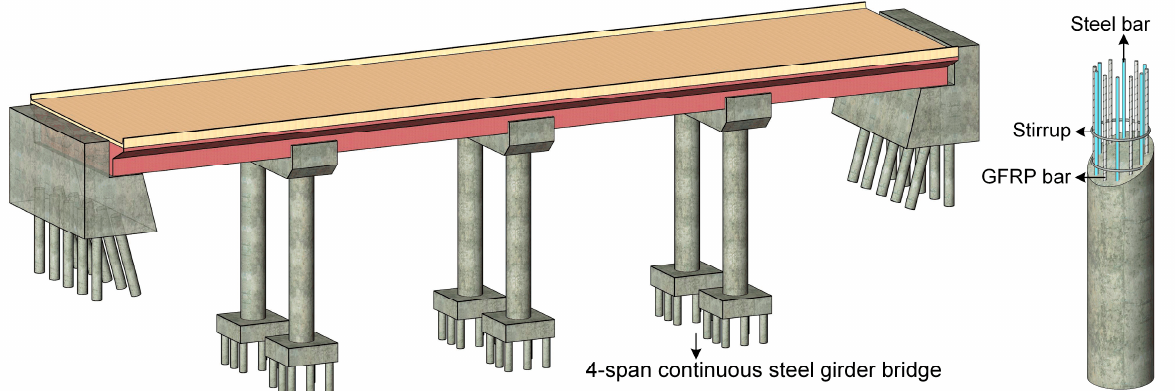
Figure 13. Schematic diagram of the analyzed HRC bridge.